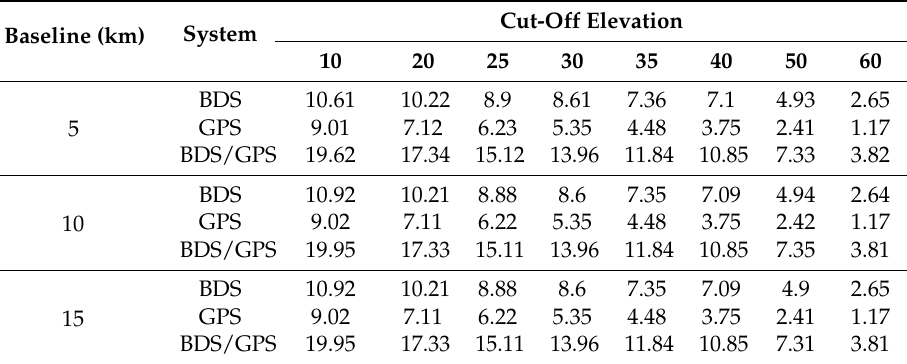
Table 2. Number of satellites for different cut-off